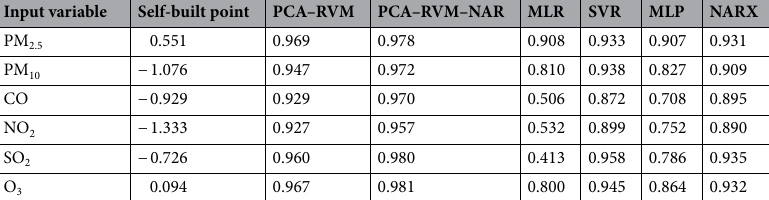
Table 4. The R 2 of self-built point and various air quality prediction models, in which national control point is used as comparison object.